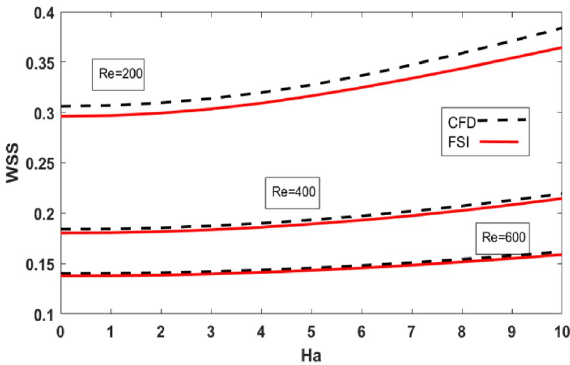
Figure 10. WSS along the upper wall vs Ha for different Re.